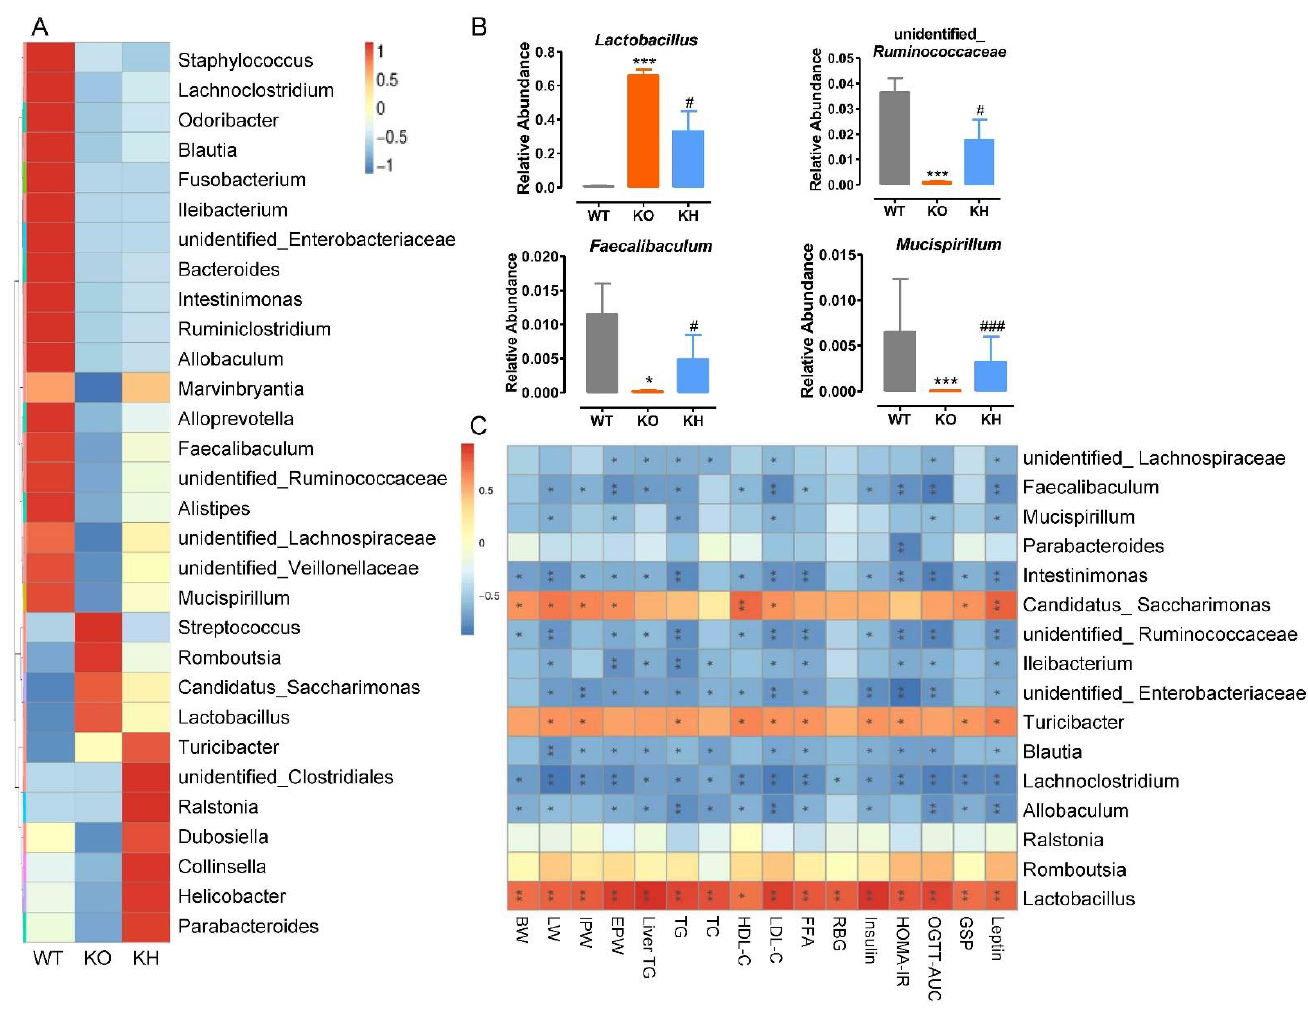
Figure 10. HTE altered the gut microbiota composition in Lepr −/− rats. ( A ) The heatmap of the top 30 genera among the various groups; ( B ) relative abundance of the gut microbiota at the genus level ( p < 0.05); ( C ) heatmap of spearman’s correlation between microbiota and obesity related parameters, significant correlations are marked as * p < 0.05, ** p < 0.01. BW, body weight of rats; LW, liver weight; IPW, inguinal fat weight; EPW, epididymal fat weight. * p < 0.05, *** p < 0.001 versus WT group; # p < 0.05, ### p < 0.001 versus KO group ( n = 4 −5, means ± SEM).